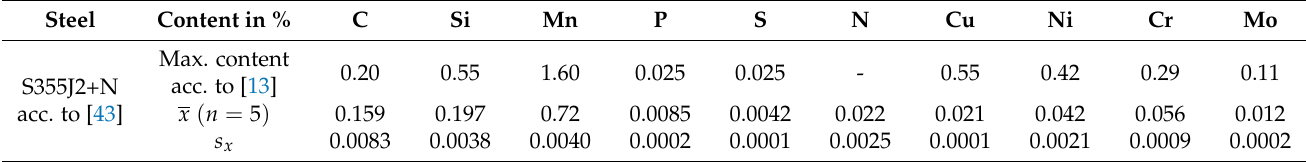
Table 4. The OES analysis results and content limits according to EN 10025-2 [13].